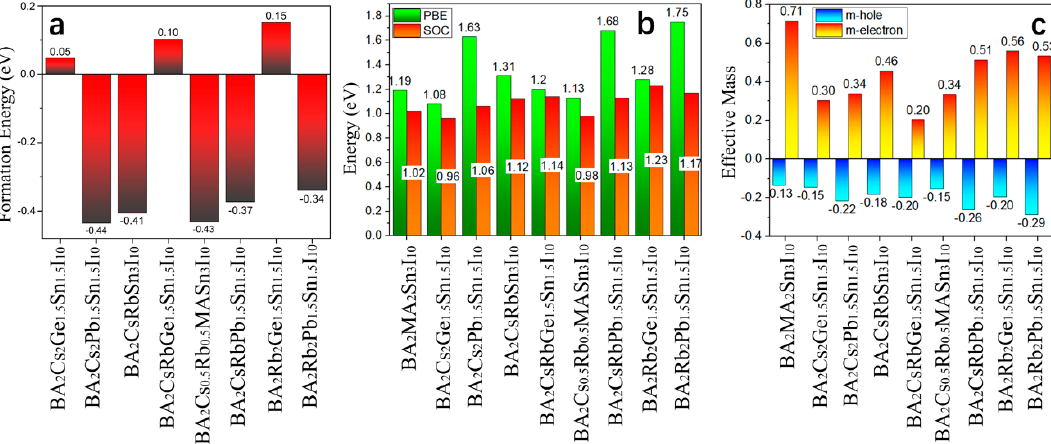
Figure 5. Carrier effective mass for 2D-HOIPs by mixing Ge/Pb atom at different concentrations (0%, Figure 5. Carrier e ff ective mass for 2D-HOIPs by mixing Ge / Pb atom at di ff erent concentrations (0%, 25%, 50%, 75% and 100%): ( a ) SnI-2D-HOIPs and ( b ) SnBr-2D-HOIPs.